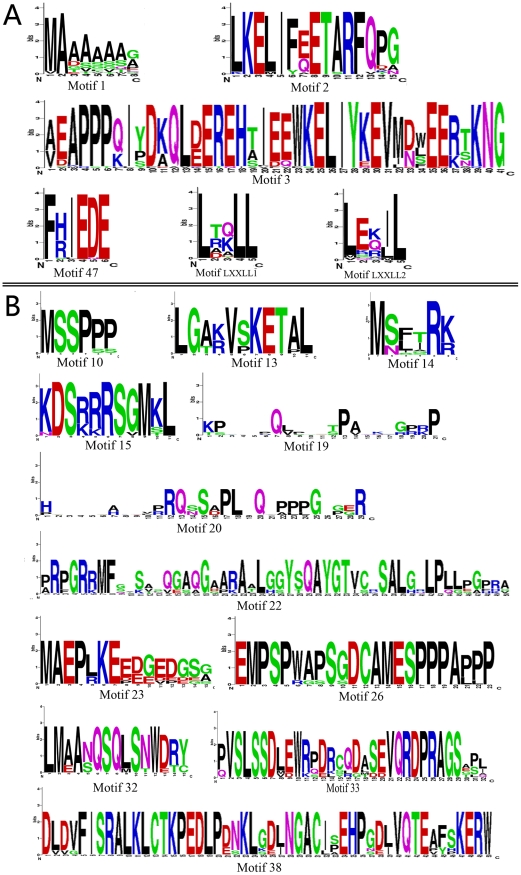
Sequence logos of some specific motifs identified in this study.(A), the motifs shared by at least two vertebrate MAPK subfamilies. (B), the motifs specially found in higher vertebrate taxa. The character and size of each logo represent the proportion of an amino acid at the specific site. The sequence logos were generated by the web-based program WEBLOGO 3. The sequence logos of other motifs are shown in Figure S6.